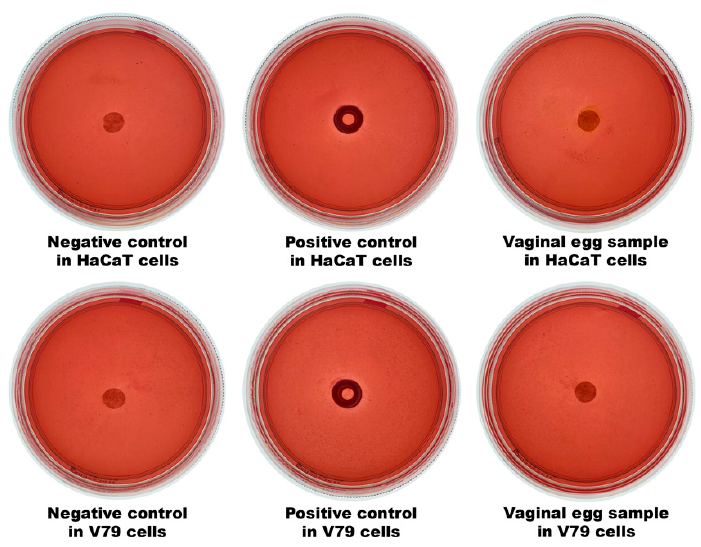
Figure 17. Results obtained in the analysis of the potential for cytotoxicity of the vaginal egg inte- grating the cocktail of lytic phage particles, via the agar disk-diffusion method with HaCaT and V79 cell